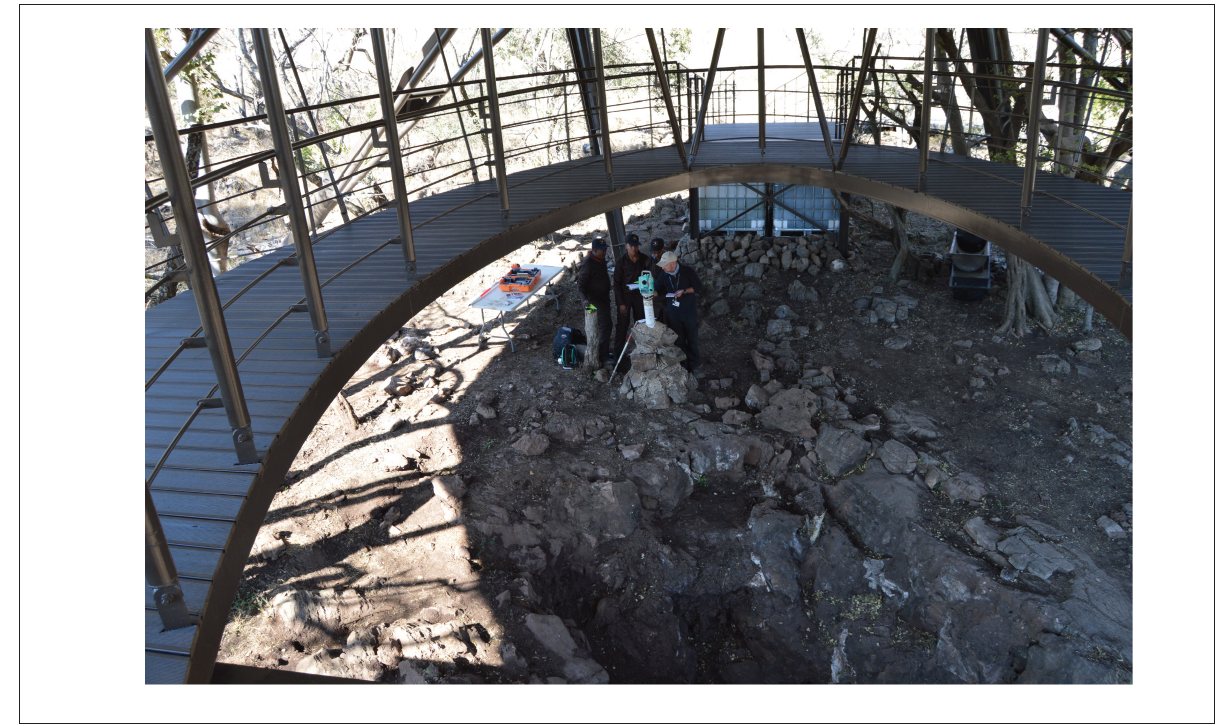
The use of conventional coordinate capture methods during excavations at Malapa Cave, Cradle of Humankind. The excavators are using a Nikon NPR-352 total station mounted on a known-position survey point to record the position of fossil material recovered during the excavation process. Site coordinates ( x, y and z ) are converted to geo-reference coordinates (easting, northing and height above sea level in the WGS 84 map reference system) by the total